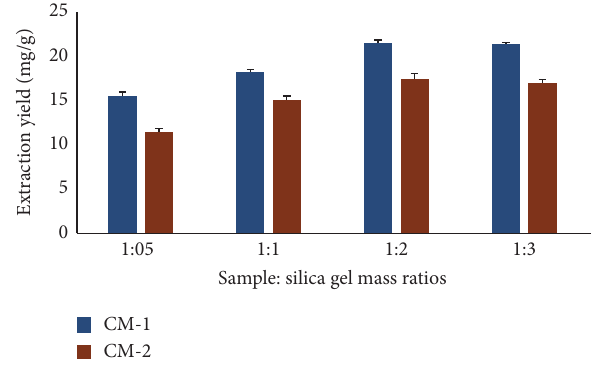
Figure 3: Effect of the sample sorbent mass ratio.